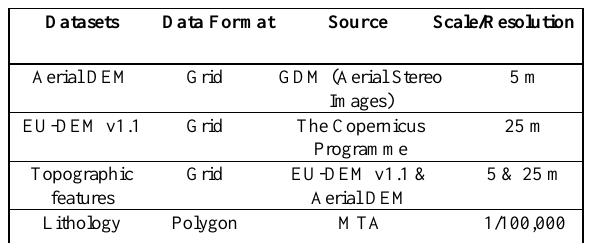
Table 2. The input features as landslide conditioning factors and their data sources used in the study.